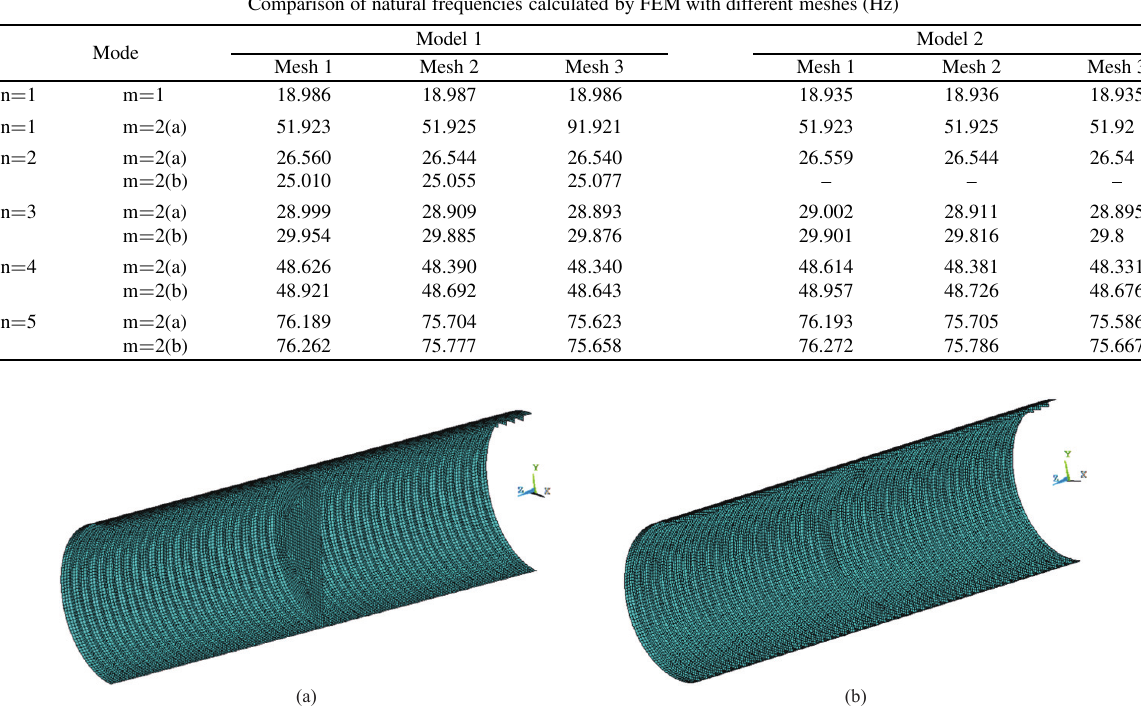
Fig. 6. FEM models of the two computation models with mesh 2 (a) Model M1 (b) Model